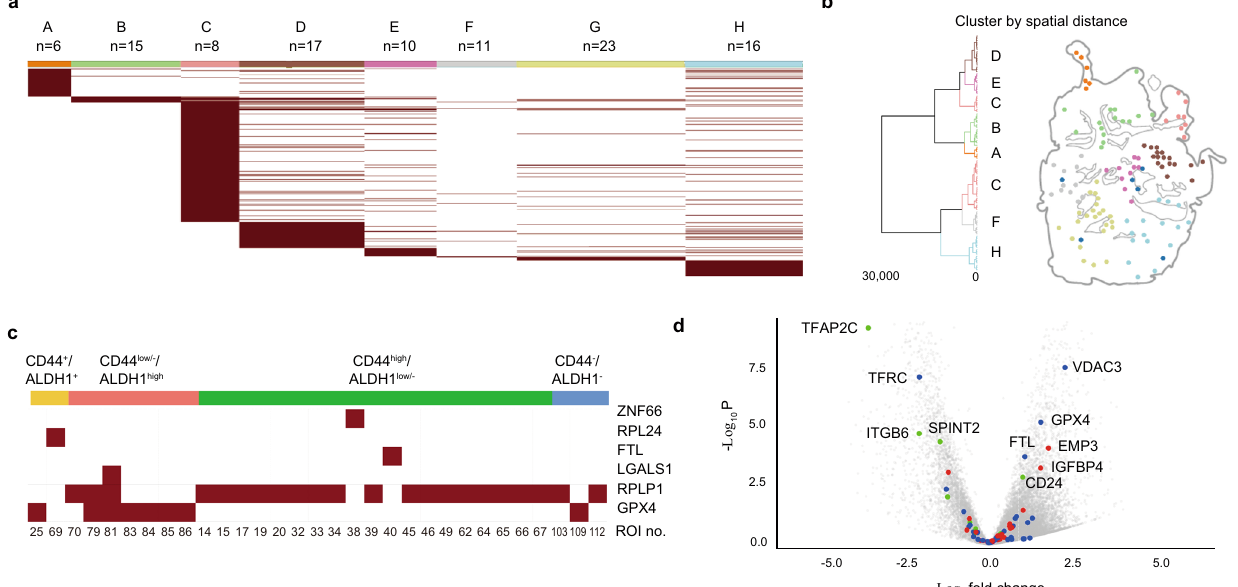
Fig. 6 Non-synonymous A-to-I editing signatures are preserved in the stiaining microniche groups. Source data are provided as a Source Data fi le. a A-to-I editome of distant-clustered ROIs show preserved A-to-I signatures. b Tree with height clustered with physical distance between ROIs (left) and distribution of these clusters in the tissue. c A heatmap of single-base RNA editing event in selected genes related to iron mediation. d Volcano plot of fold change values of genes in samples with A-to-I-edited GPX4 variants compared to those without the variant. Microniches from four TNBC tissues (from patients B, C, D, and E) were analyzed. Blue dots indicate ferroptosis-related genes, red dots indicate upregulated genes in CSCs, and green dots indicate downregulated genes in CSCs. method showed that the group with a high frequency of the GPX4 which patients had the GPX4 variants that included A-to-I-edited 1106616 variant at the transcriptome level (positive ferroptosis variants, SNPs or somatic mutations at the genome level. We gene set enrichment value) showed a trend toward worse clinical observed the gene set related to ferroptosis was highly enriched outcomes compared to the group with a low frequency of the when the median frequency of the GPX4 variant in the transcript variant (Supplementary Fig. 10). Furthermore, we compared the data was higher (Supplementary Fig. 10). The overall survival correlation of survival with a combination of ADAR genes, total rates of the two groups estimated using the Kaplan – Meier NATURE COMMUNICATIONS| (2022) 13:2540